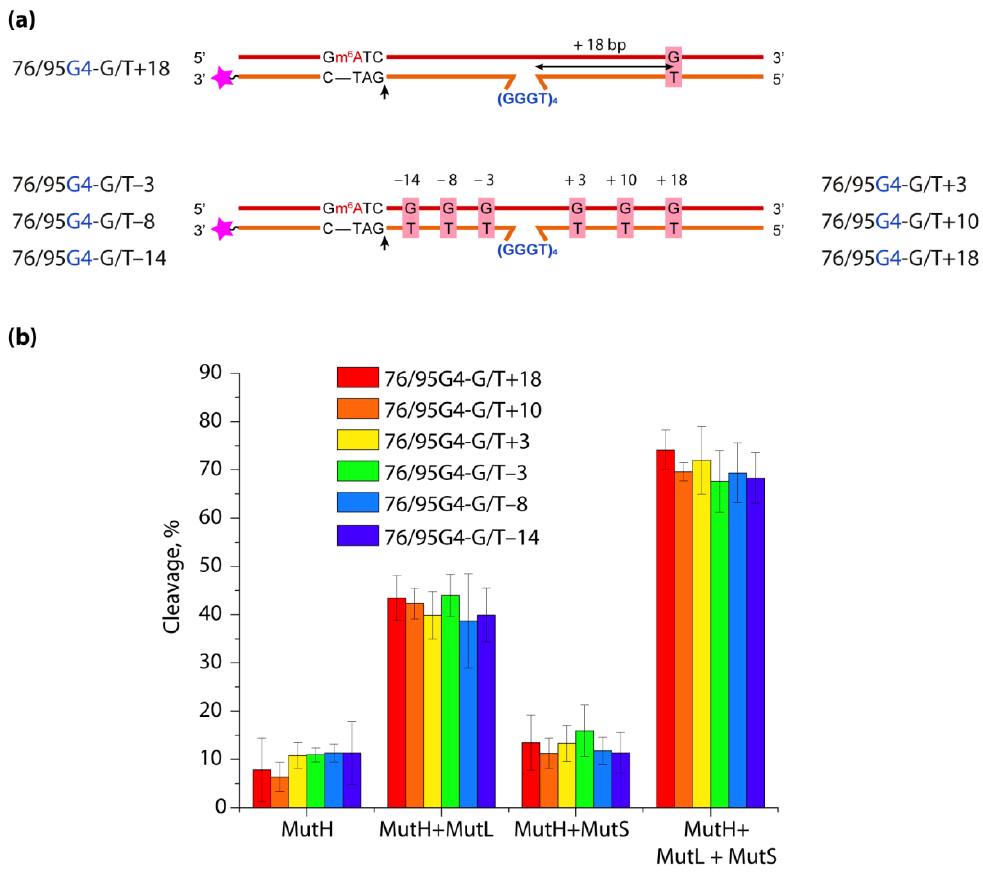
Figure 7. Efficiency of ecMMR protein-induced hydrolysis of linear DNA duplexes with an embedded parallel G4 and a MutH recognition site, which differ in the mismatch position. ( a ) DNA models used in this work; their names are shown on the left and right, and the sequences are the same as in [35]. 5 (cid:48) -Gm 6 ATC-3 (cid:48) /3 (cid:48) -CTAG-5 (cid:48) corresponds to MutH recognition site, and black arrows indicate the position of DNA cleavage by the MutH endonuclease. Pink asterisks represent the TAMRA fluorophore at the 3 (cid:48) -end of the unmethylated daughter strand. 3 (cid:48) -Labeled cleavage products were separated from intact DNA strands by gel electrophoresis under denaturing conditions (7 M urea), allowing for evaluation of nicking potency; for the experimental conditions, see [35]. ( b ) Efficiency of DNA hydrolysis induced by ecMMR proteins ( p < 0.05). Data were obtained for the MutH alone (250 nM concentration) and for the combinations of MutH with 250 nM MutS or 250 nM MutL, as well as with both 250 nM ecMutS and 250 nM ecMutL (all protein concentrations were calculated per monomer). The reaction mixtures were incubated at 37 ◦ C for 1 h. These results have not yet been